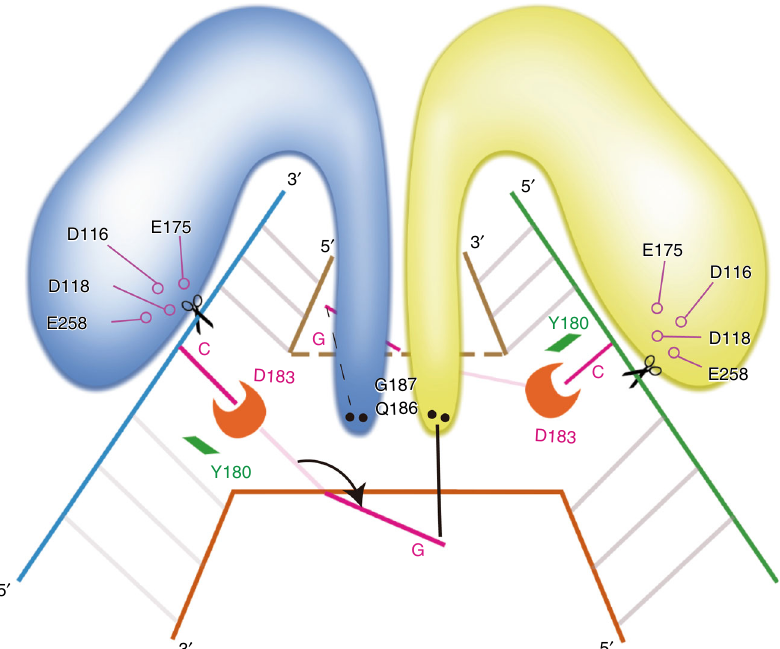
Fig. 6 Proposed working model for cytosine-dependent HJ resolution by NtMOC1. The blue and yellow models indicate the protein protomers. The dimeric enzyme penetrates into the junction, and the two residues Y180 and D183 from the BR loop protrude into the duplex and disrupt the base pairing at the crossover. Y180 intercalates into the bases, whereas D183 recognizes the cytosine prior to the cleavage site. The fl ipped-out guanine is further stabilized by residues from the N-terminal helical bundle (Q186 and G187). Four acidic residues constitute the catalytic tetrad, hydrolyzing the phosphodiester bond in a cytosine-dependent AATCG-3 ′ ; 5 ′ -CCAGTGCCTTGCTGGGACATCTTTGCCC-3 ′ ; 5 ′ -TAGACAG CTCCATCCAGCAAGGCACTGG-3 ′ ; 5 ′ -CGATTACAACAGAGGATGGAGCTG TCTA-3 ′ . The underlined nucleotides indicate the 2-bp homologous cores at the crossover) were resolved in lysis buffer (25 mM Tris-HCl, pH 8.0, 150 mM NaCl) and mixed at an equimolar ratio and incubated in boiled water and gradually cooled to room temperature. Several X2 (CCGG) variants were derived similarly by mutation of the CCGG core sequences. To obtain co-crystals, a series of truncated HJs with varying arm length and CCGG core sequences were similarly annealed. The individual oligo sequences used for HJ annealing are deposited in Supple- mentary Table 3. statistics are summarized in Supplementary Table 1. All fi gures were generated using the program PyMOL (http://www.pymol.org/). Electrophoretic mobility shift assay (EMSA) . Proteins were incubated with approximately 250 nM HJ substrates in a volume of 10 μ l containing the binding